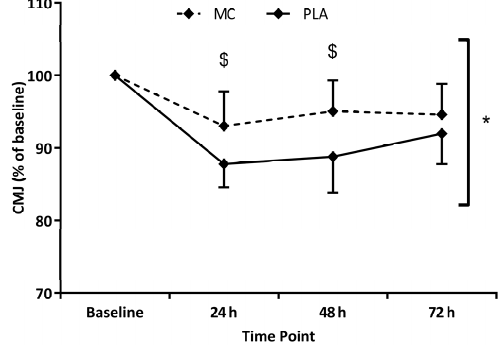
Figure 3. Comparison of countermovement jump (CMJ) height with Montmorency cherries (MC) or